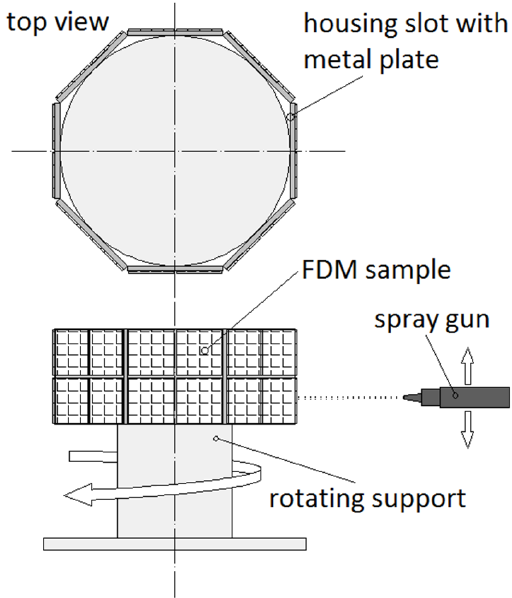
Figure 3. Schematization of the APS deposition.